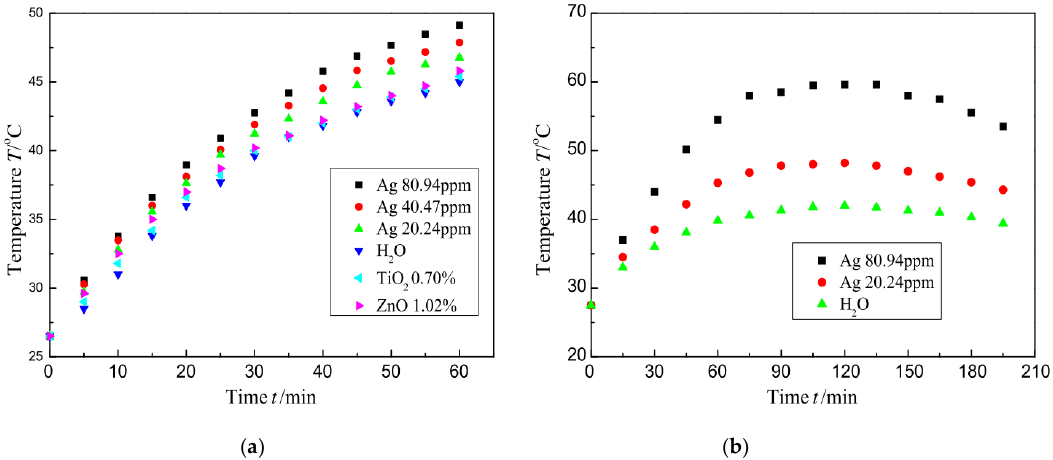
Figure 14. Characteristic curve of the temperature rise of nanofluids under ( a ) simulated and ( b ) natural sunlight conditions [61]; 2018, IOSR.